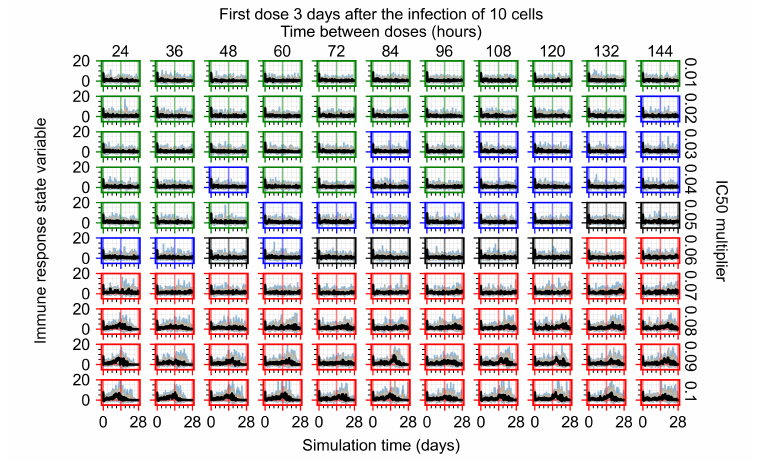
Figure A38. Immune response state variable number. Positive values correspond to an inflammatory state, and negative to an anti-inflammatory state.